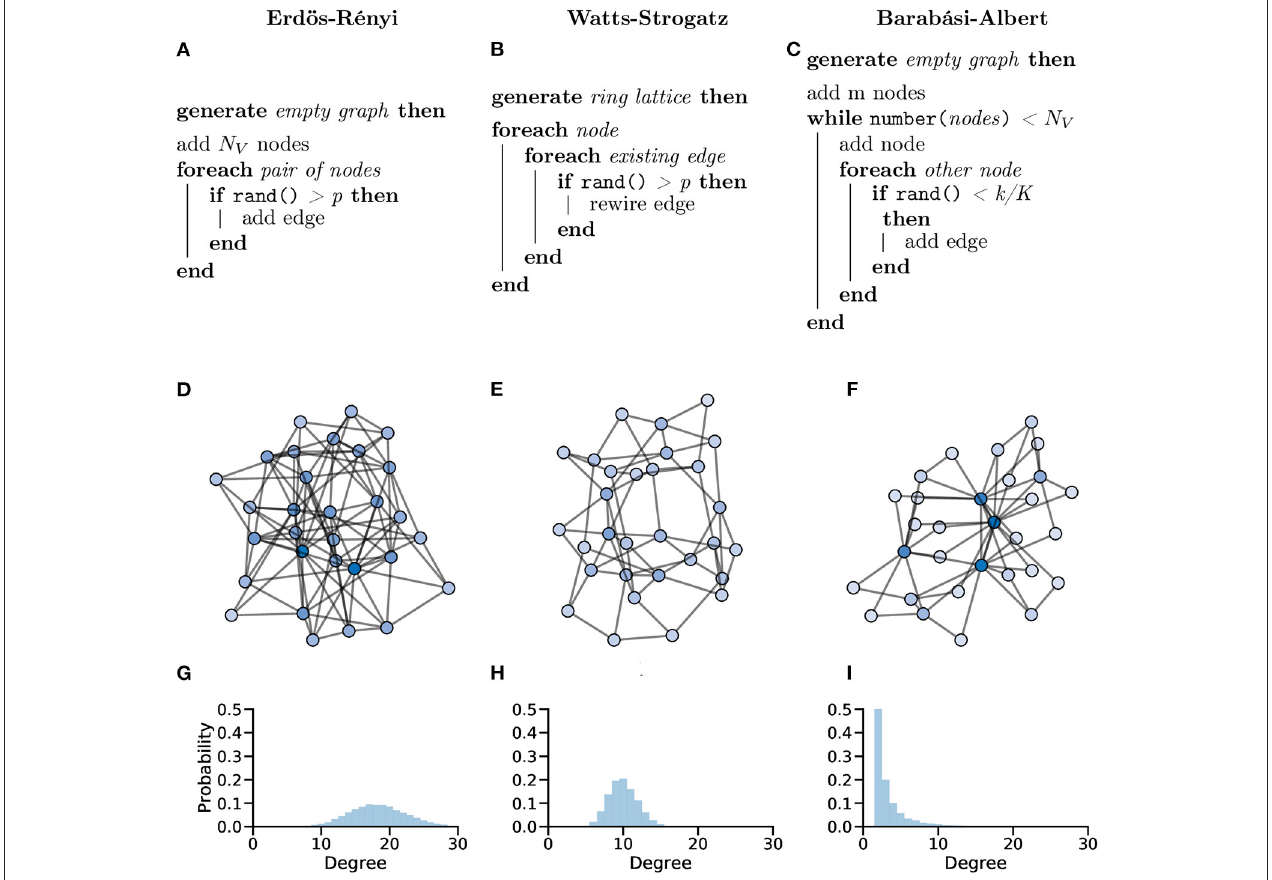
FIGURE 10 | Random graphs, which can be used as in silico models or controls, can be generated in different ways giving the graphs different properties. Pseudocode showing the processes used to create Erdös-Rényi (A) , Watts-Strogatz (B) and Barabási-Albert (C) model graphs. (D–F) Example graphs with N V = 30 showing clearly different organisations for different generation models. (G–I) Probability distributions of node degree over graphs generated with N V = 10,000 showing lower average degree and increased tails in both the Watts-Strogatz (H) and Barabási-Albert (I) models.